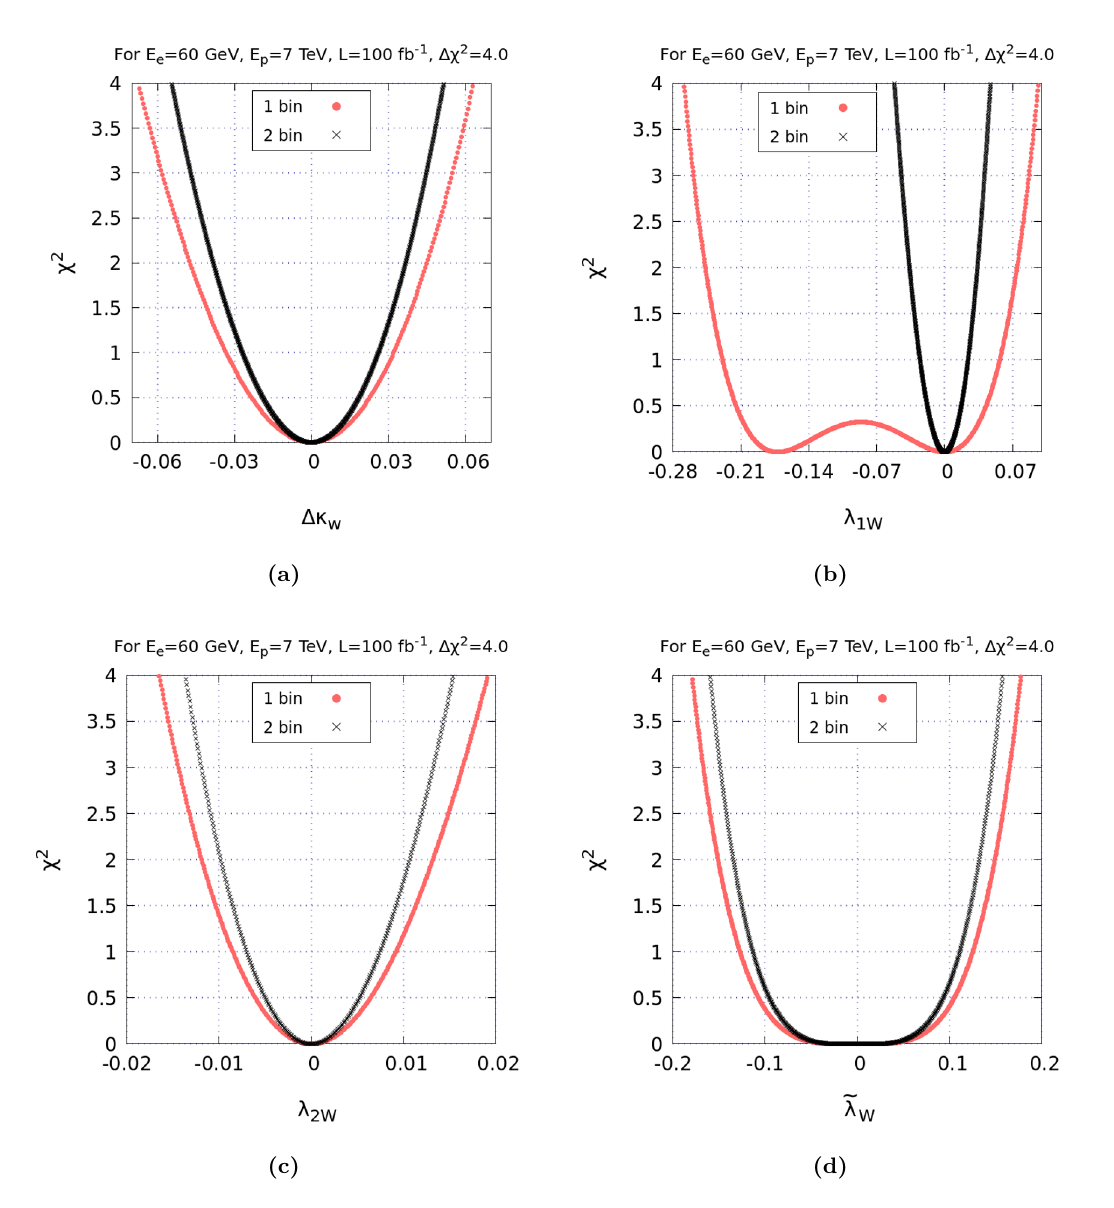
Figure 5 . χ 2 distribution for 1 bin (red curve) and 2 bins (black curve) of ∆ φ distribution in the CC process. In (a), we have defined ∆ κ W = 1 − κ W